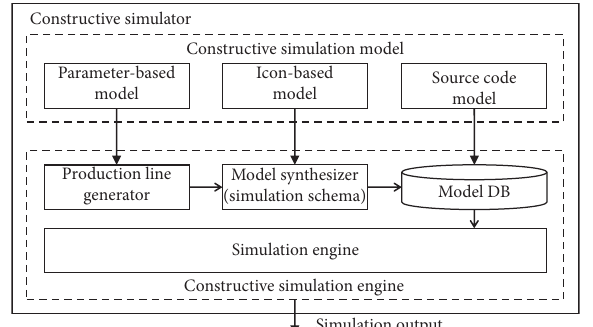
Figure 6: Concept of constructive simulation in smart manufacturing.